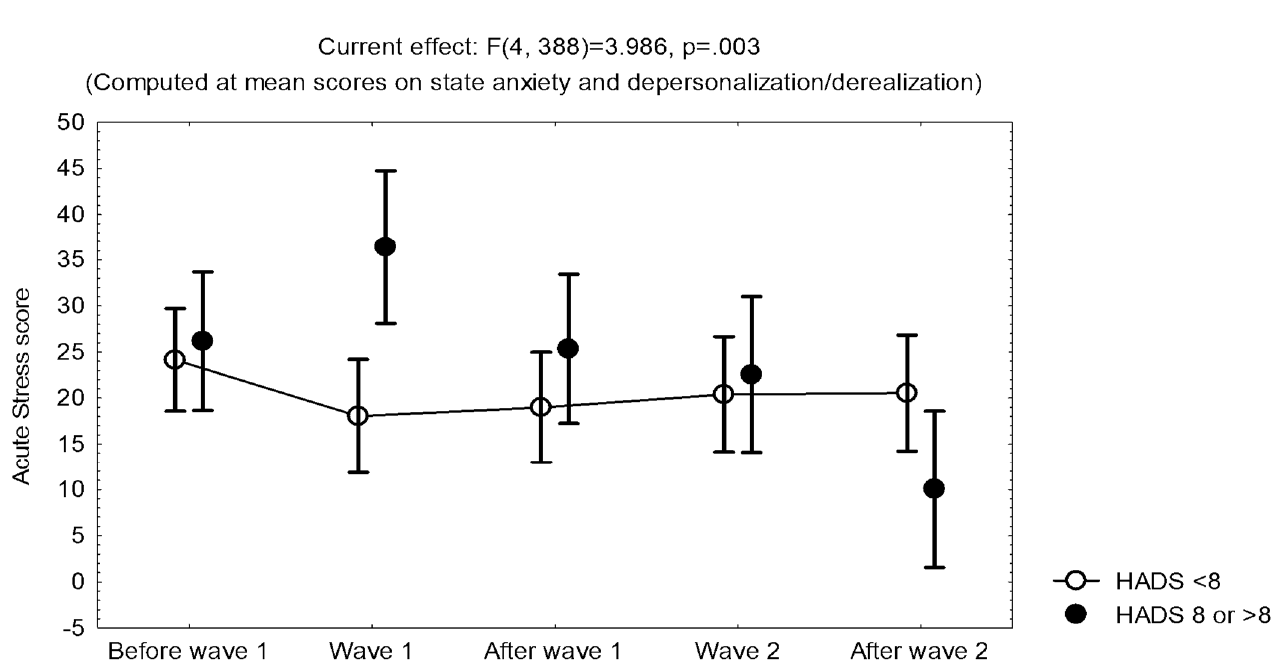
Figure 2. Mean and standard error of the mean of the scores on the Stanford Acute Stress Question- naire during the 5 evaluations in Group I ( n = 109), according to the score on the Hospital Anxiety and Depression Scale (HADS) (< 8 or ≥ 8).